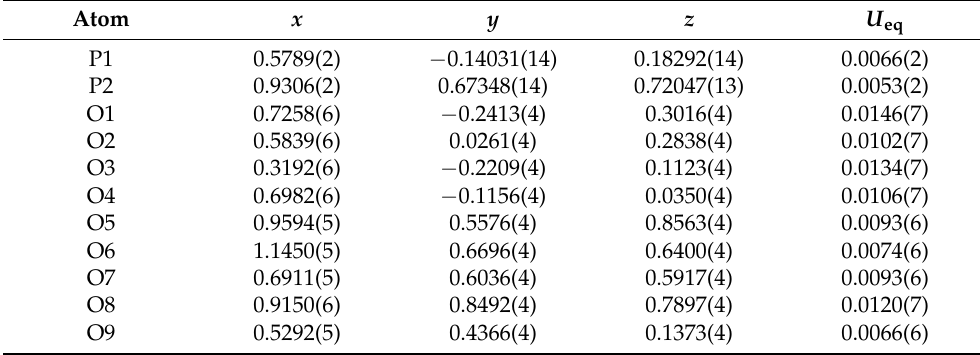
Table A2. Fractional atomic coordinates, site occupancy factors (S.O.F.) and isotropic